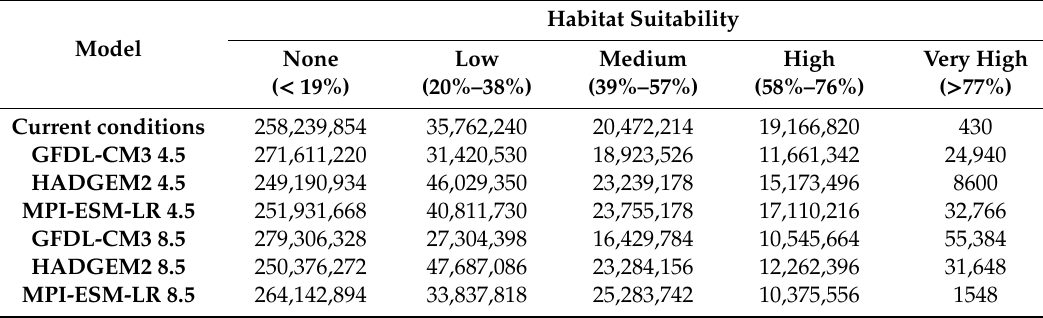
Table 2. Habitat suitability of candelilla in Mexico and the